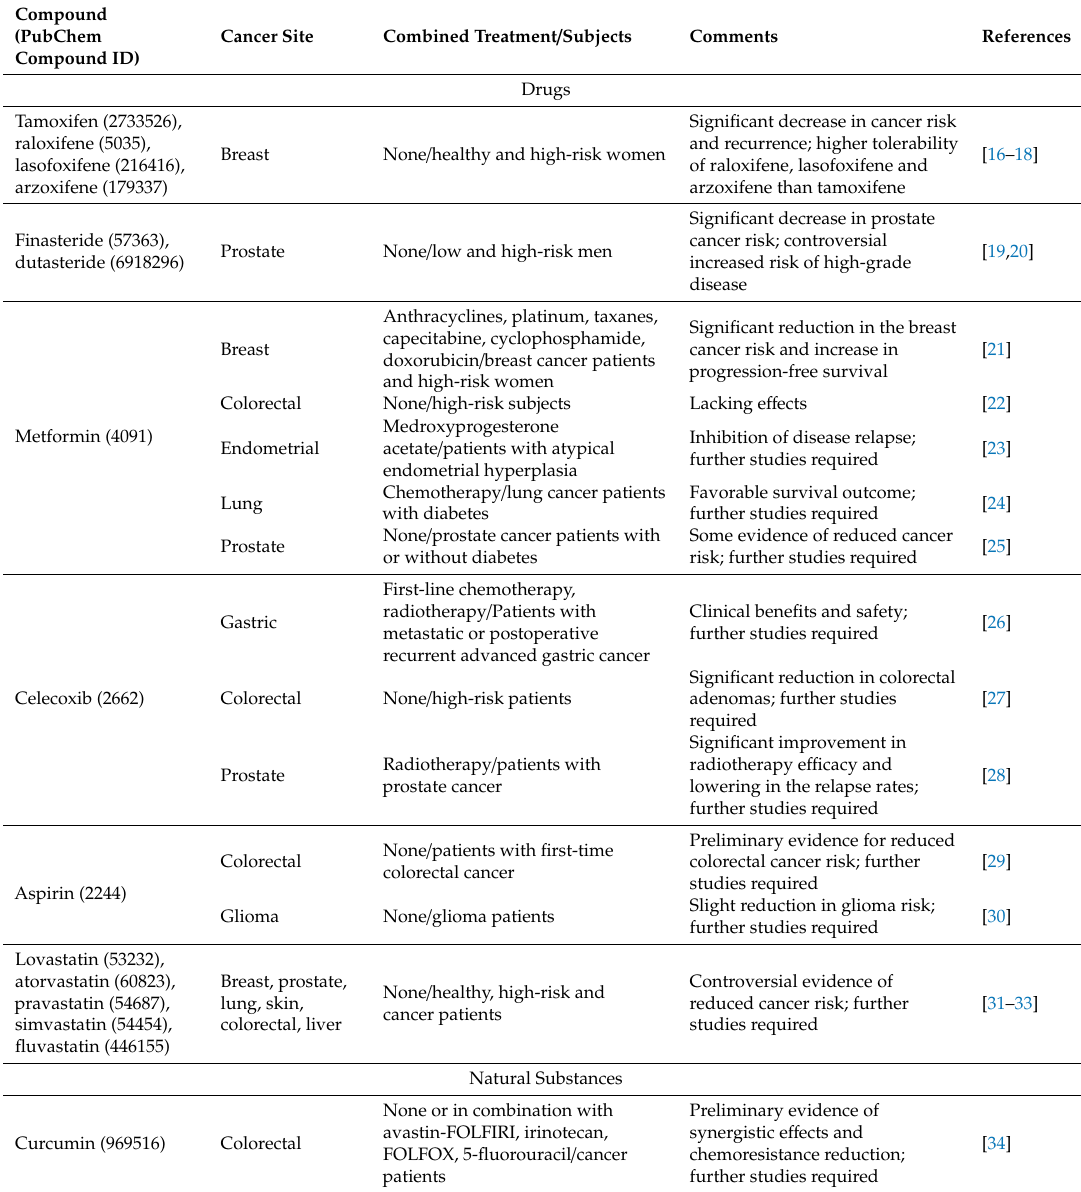
Table 1. Some examples of drugs and natural substances evaluated as cancer preventive agents in clinical